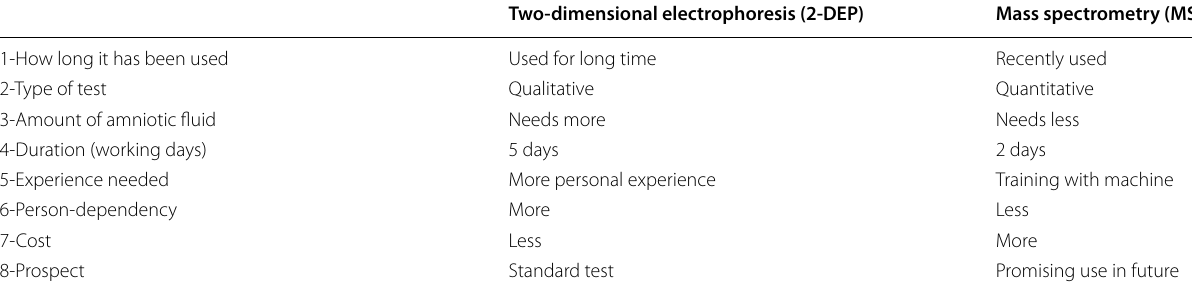
Table 2 Comparison between 2-DEP & MS